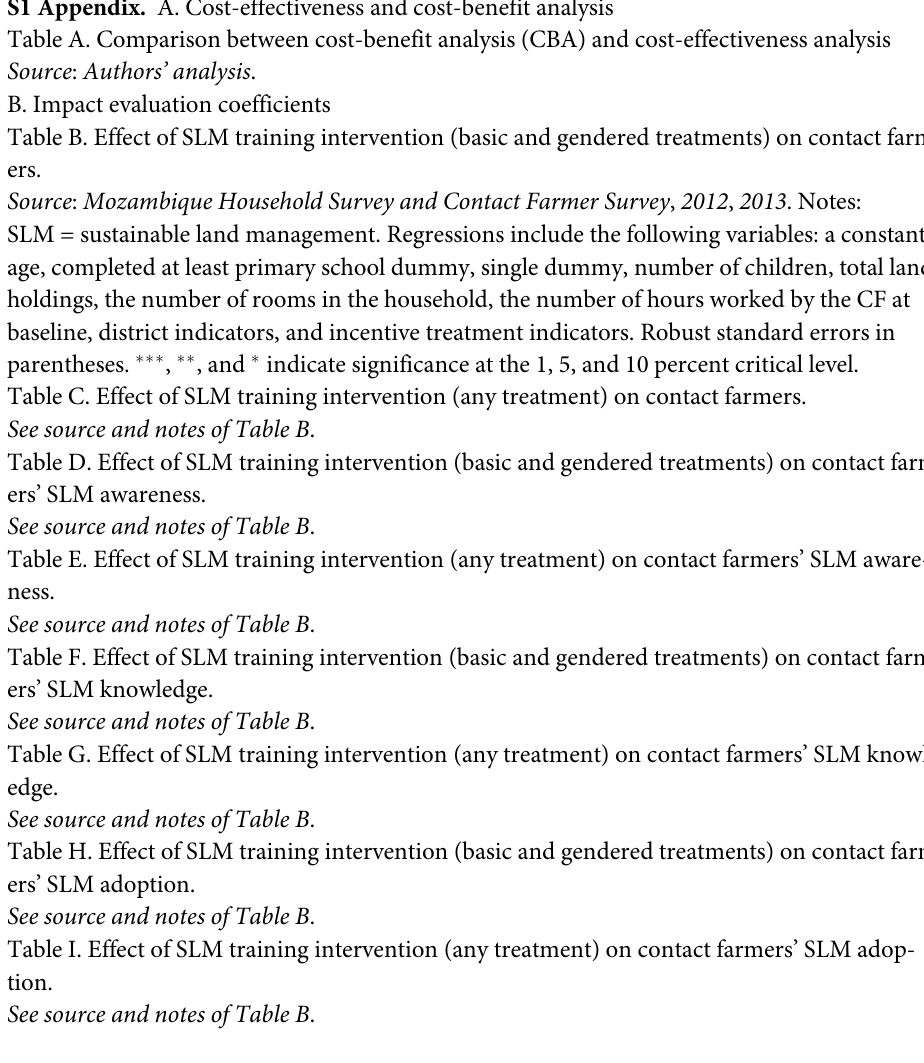
Table B. Effect of SLM training intervention (basic and gendered treatments) on contact farm-